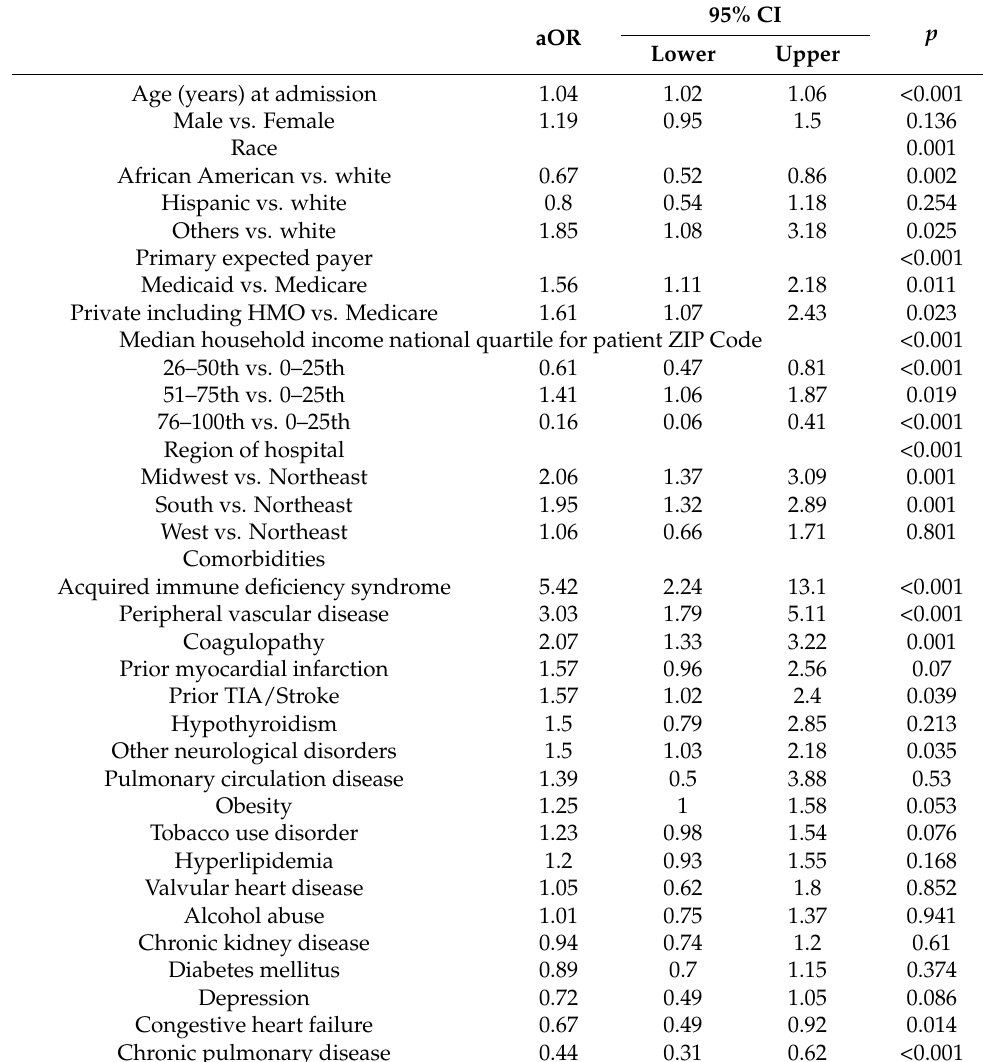
Table 5. Predictors of MACCE in Hypertensive Crisis-related Admissions among Young Patients with Cannabis Use